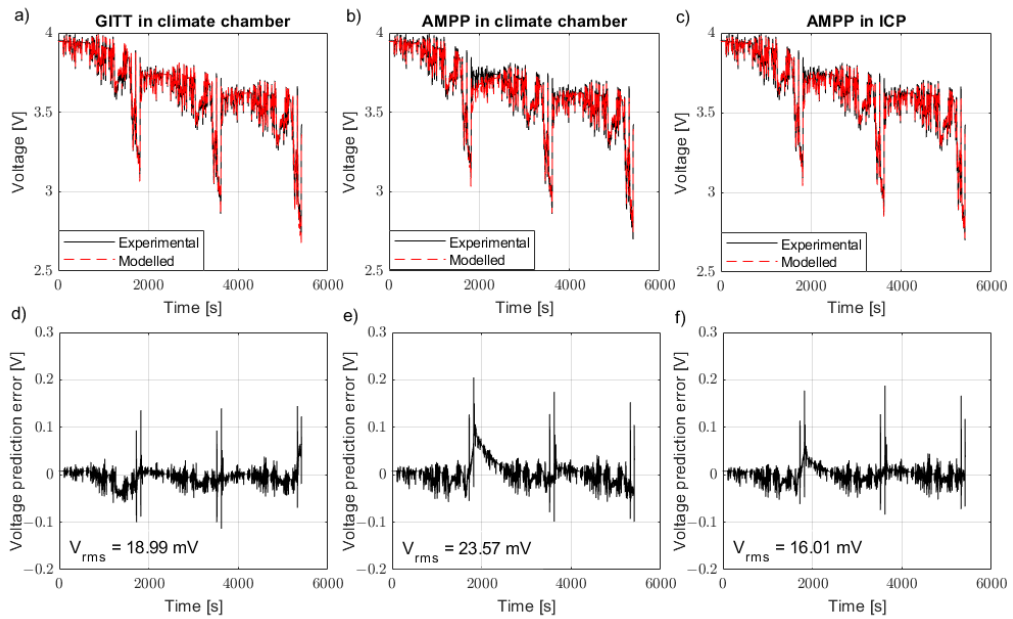
Figure 5. Drive cycle validation along with associated error for the model parametrised using the GITT data in the climate chamber, AMPP data in the climate chamber and AMPP data in the ICP at 10 °C. The comparison of the ECM to experimental drive cycle data is shown in subfigures ( a – c ), whilst their associated error is shown in subfigures ( d – f ).